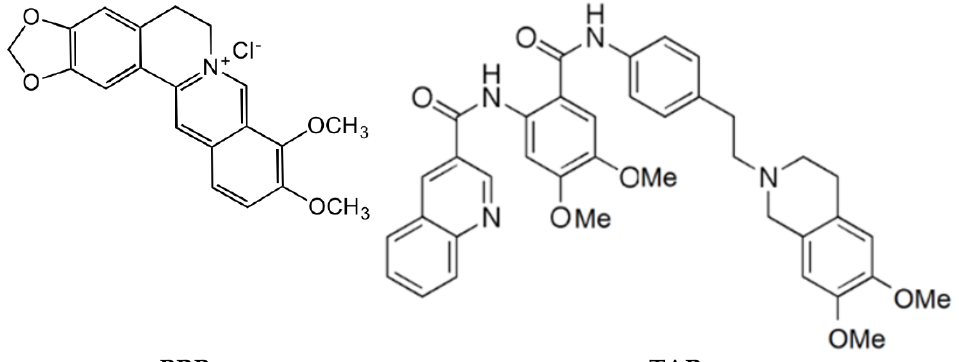
Figure 1. Chemical structures of berberine chloride and tariquidar .